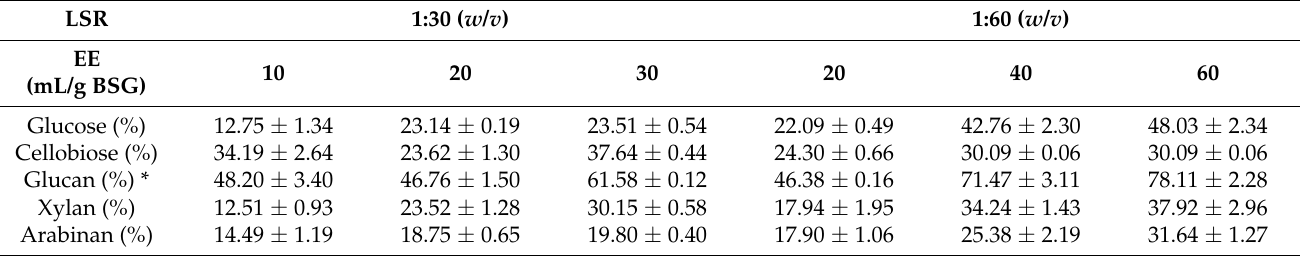
Table 2. Hydrolysis of CRM catalyzed by the enzymatic extract of T. reesei